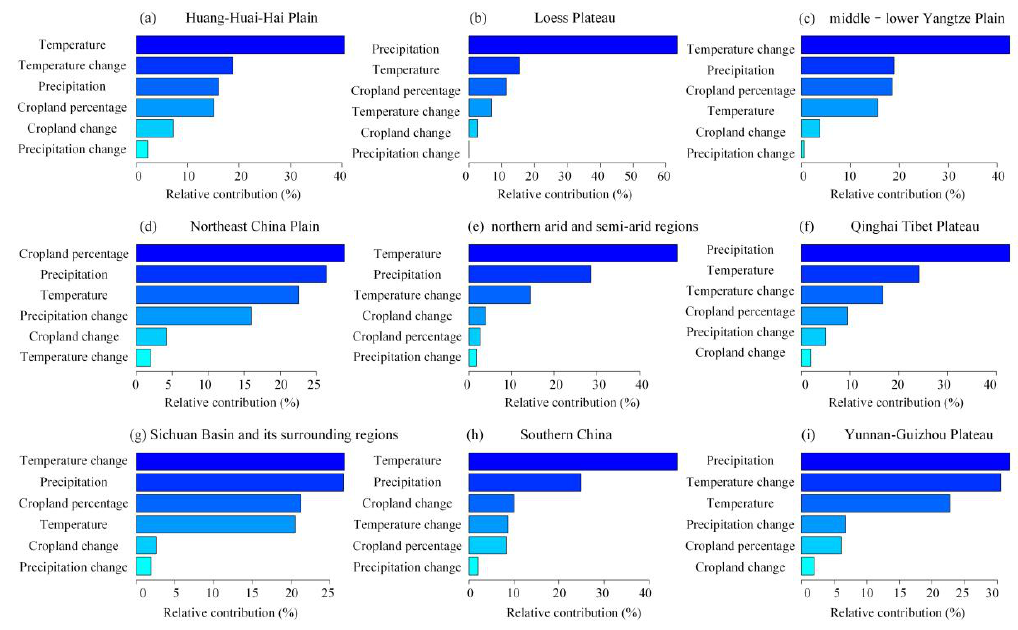
Figure 9. Relative contributions of cropland and climate data on GLASS NDVI trends from 1982 to 2015 in the ( a ) Huang-Huai-Hai Plain, ( b ) Loess Plateau, ( c ) middle–lower Yangtze Plain, ( d ) Northeast China Plain, ( e ) northern arid and semi-arid regions, ( f ) Qinghai Tibet Plateau, ( g ) Sichuan Basin and its surrounding regions, ( h ) Southern China, and ( i ) Yunnan-Guizhou Plateau agricultural zones.